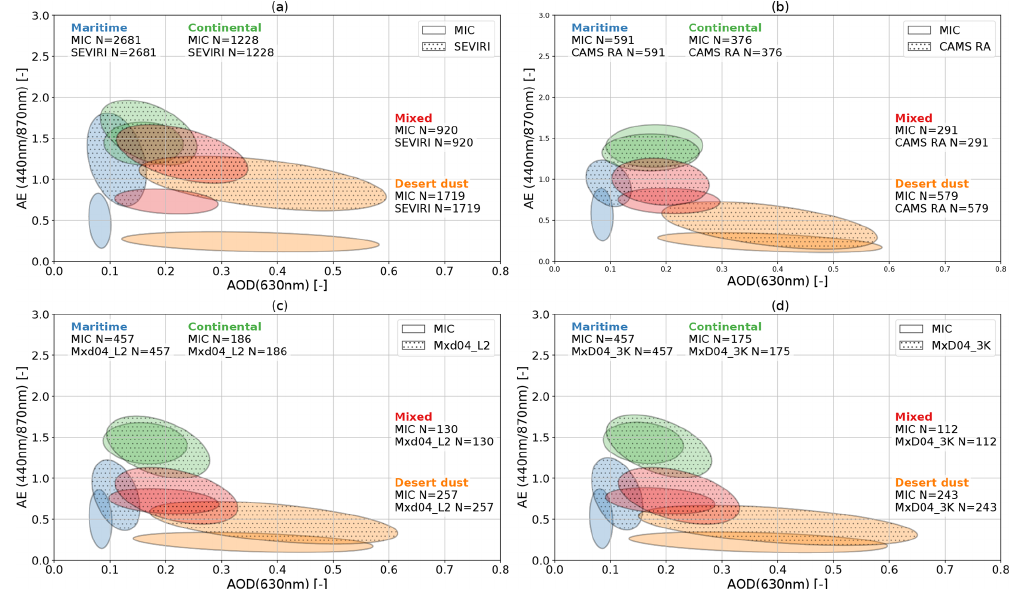
Figure 8. Same as Fig. 7, but the requirement for simultaneous data availability from all data points was dropped, and the figure also shows CAMS RA data points.